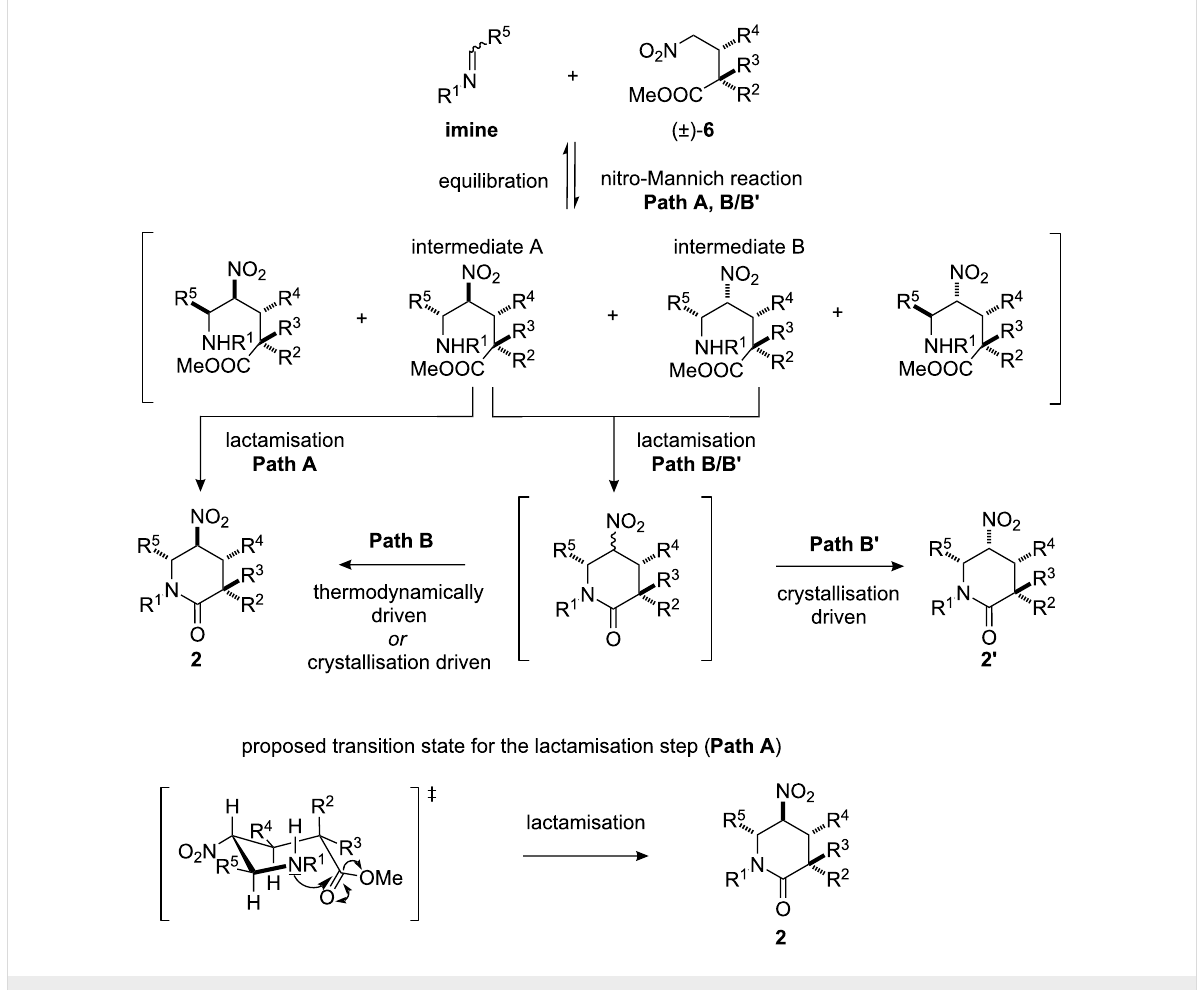
reaction conditions, epimerised at C5 to afford an identical 63:37 thermodynamic mixture of 2m / 2m’ (Scheme 7; Figure 3)